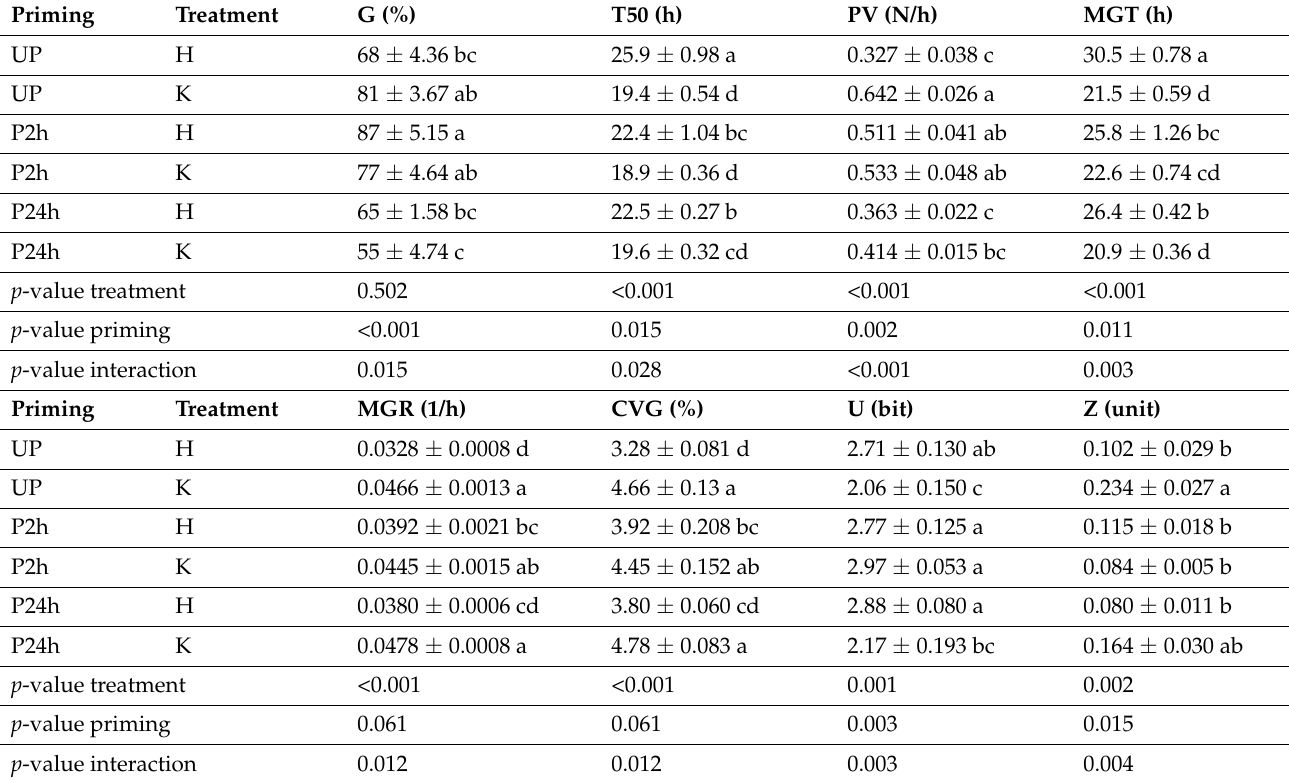
Table 1. Germination parameters calculated on unprimed M. truncatula seeds in presence/absence of 0.5 mM kinetin, 2 h-hydropriming/hormopriming and 24 h-hydropriming/hormopriming, expressed as mean of 5 replicates (5 dishes each, 20 seeds/dish) ± standard deviation. G, germinability; T 50 , time required to reach 50% of G; PV, peak value; MGT, mean germination time; MGR, mean germination rate; CVG, coefficient of velocity of germination; U, uncertainty index; Z, synchronization index; UP, unprimed seeds; P2h, 2 h-primed seeds; P24h, 24 h-primed seeds; H, water imbibition and hydropriming protocols; K, kinetin imbibition and hormopriming protocols. Values that are followed by common letters are not significantly different ( p < 0.05) as analyzed with two-way ANOVA and Tukey test. p -values are also provided referring to the difference observed between treatment comparison groups (H vs. K), priming comparison groups (UP vs. P2h vs. P24h) and their